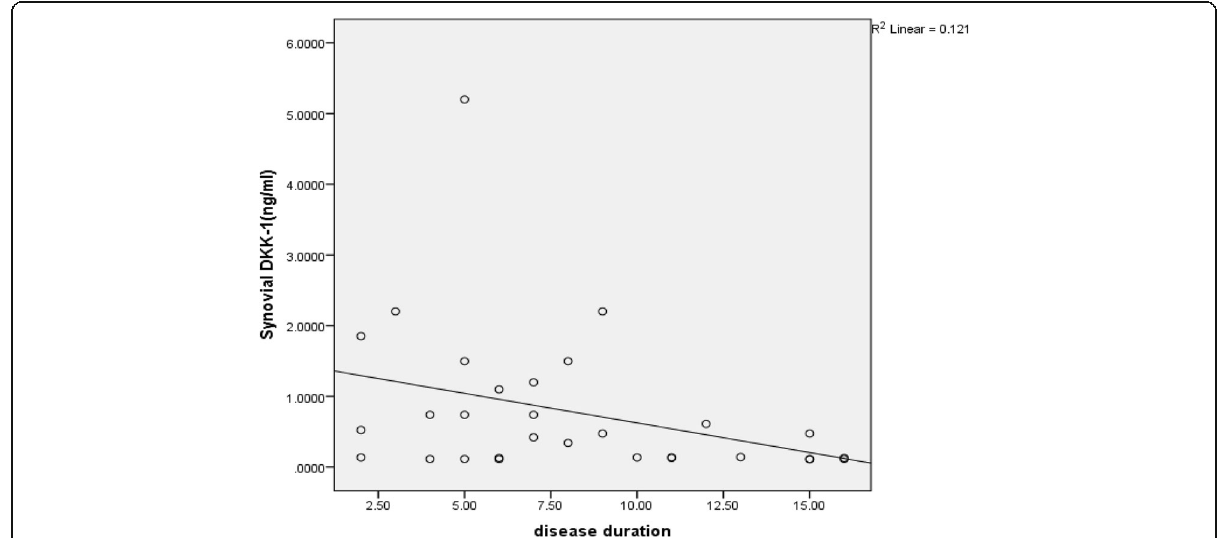
Fig. 2 Correlation between synovial Dkk-1 levels and disease duration in primary knee OA